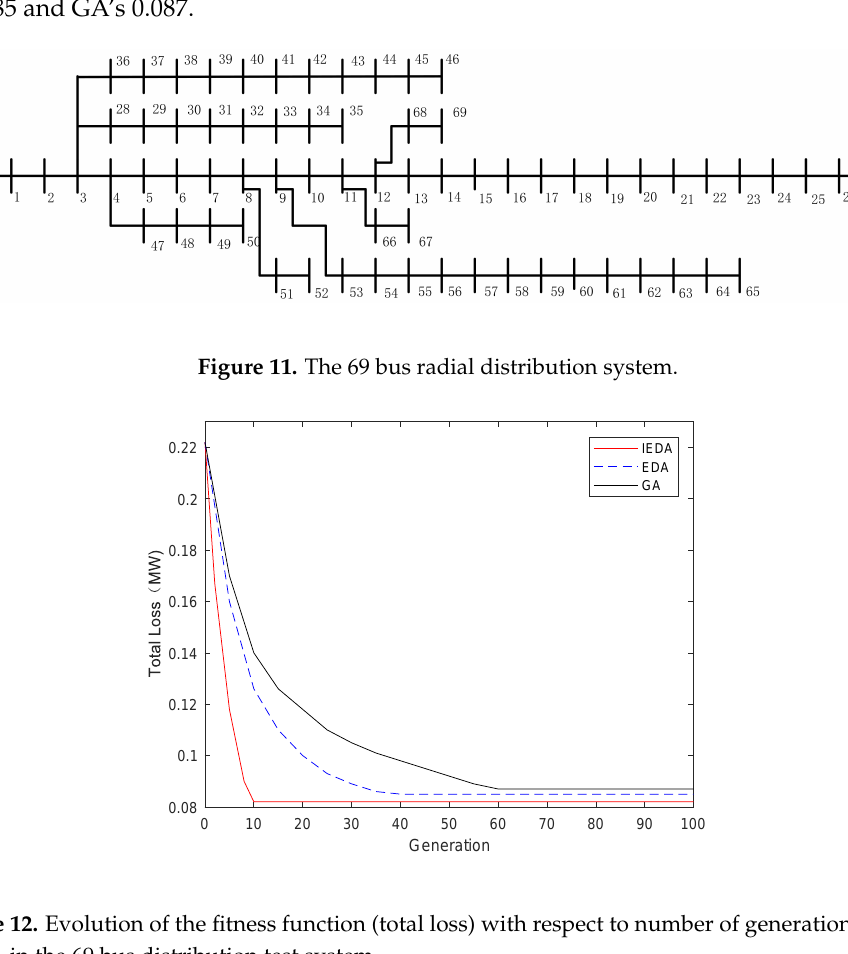
Figure 12. Evolution of the fitness function (total loss) with respect to number of generations for bus No. 61 in the 69 bus distribution test